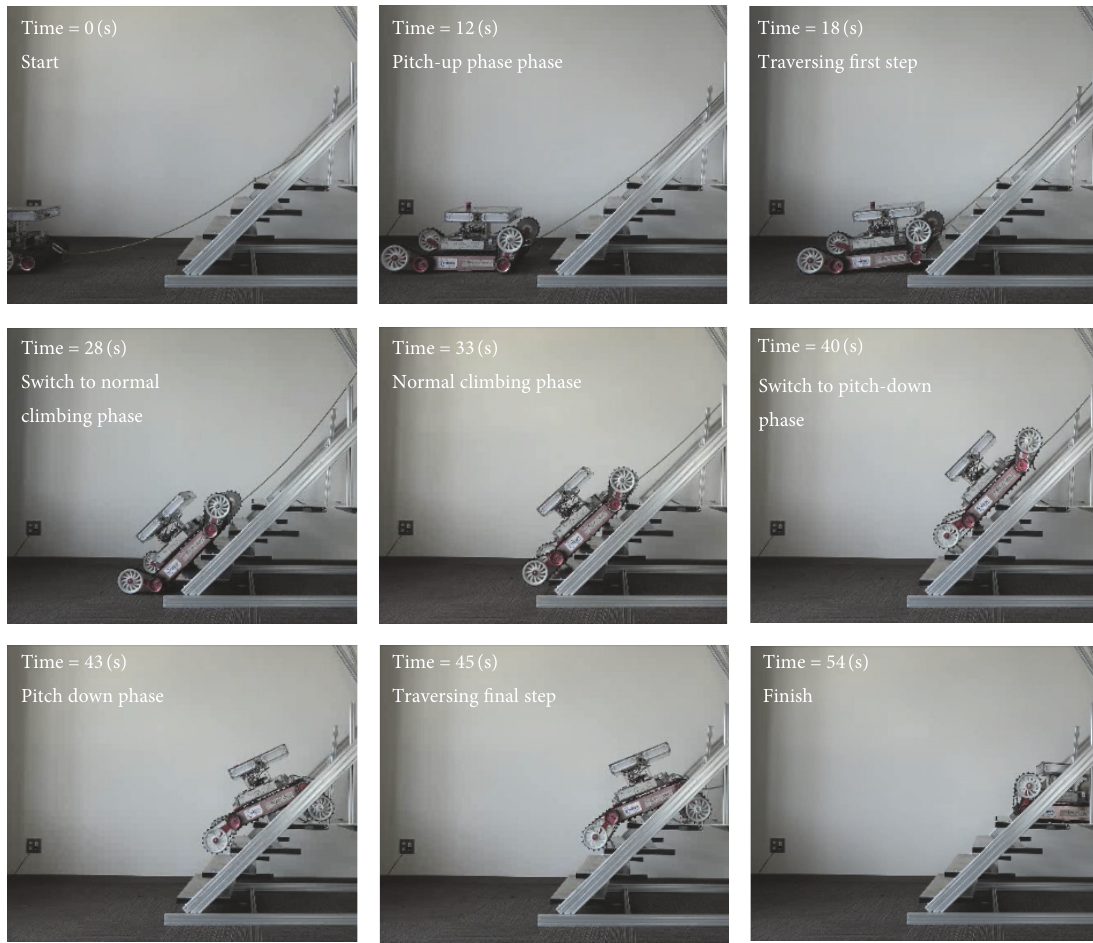
Figure 20: Climbing-up behavior for case 𝜃 𝑠 = 45 ∘ , 𝑝 = 200